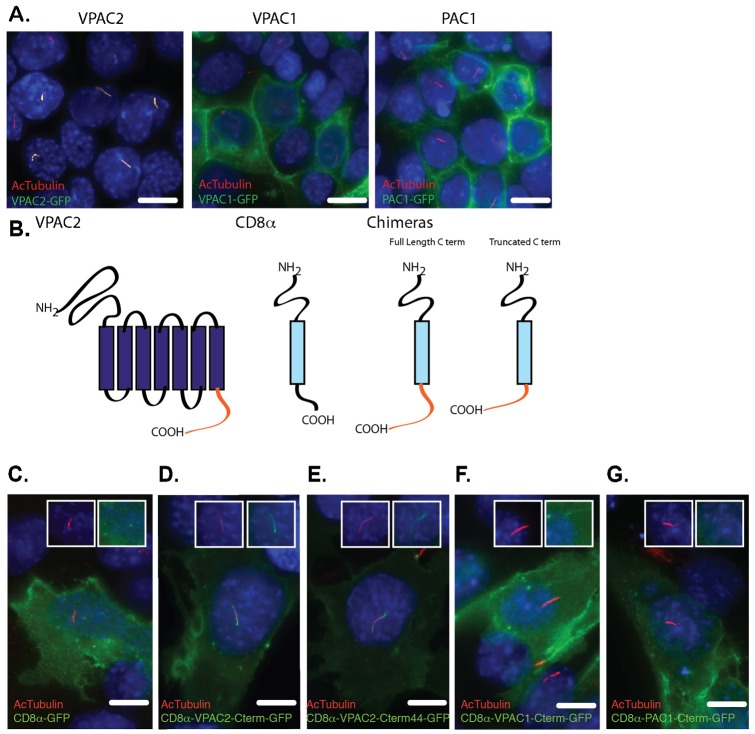
The C-terminus is sufficient and necessary for VPAC2 ciliary targeting.(A) VPAC2-GFP (but not VPAC1-GFP and PAC1-GFP) targets to primary cilia in IMCD3 cells. IMCD3 cells were transduced with lentivirus vectors expressing VPAC2-GFP, VPAC1-GFP or PAC1-GFP and were serum starved to induce ciliogenesis. Cells were immunostained for acetylated α-tubulin (AcTubulin, red). (B) Schematic of CD8α chimeras. (C–G) The last 44 amino acids of VPAC2's C-terminus are sufficient to target the non-ciliary membrane protein CD8α to primary cilia. IMCD3 cells expressing GFP-tagged CD8α, CD8α-VPAC2-Cterm, CD8α-VPAC2-Cterm44, CD8α-PAC1-Cterm and CD8α-VPAC1-Cterm were serum starved and immunostained for AcTubulin (red). DNA was labeled with DAPI (C–G). Insets show an unmerged image of the region around the cilium. Scale bars: 5 µm.